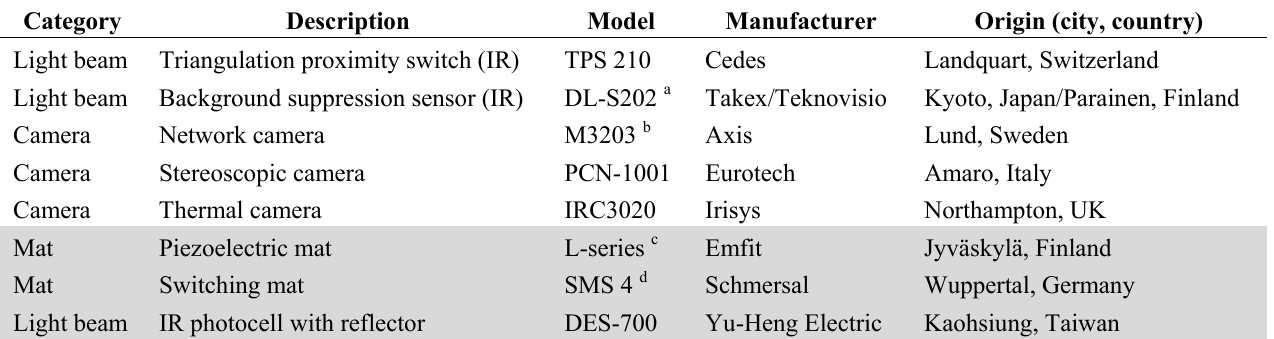
Table 1. Sensors included to the test setup. The direction insensitive sensors are shaded in gray